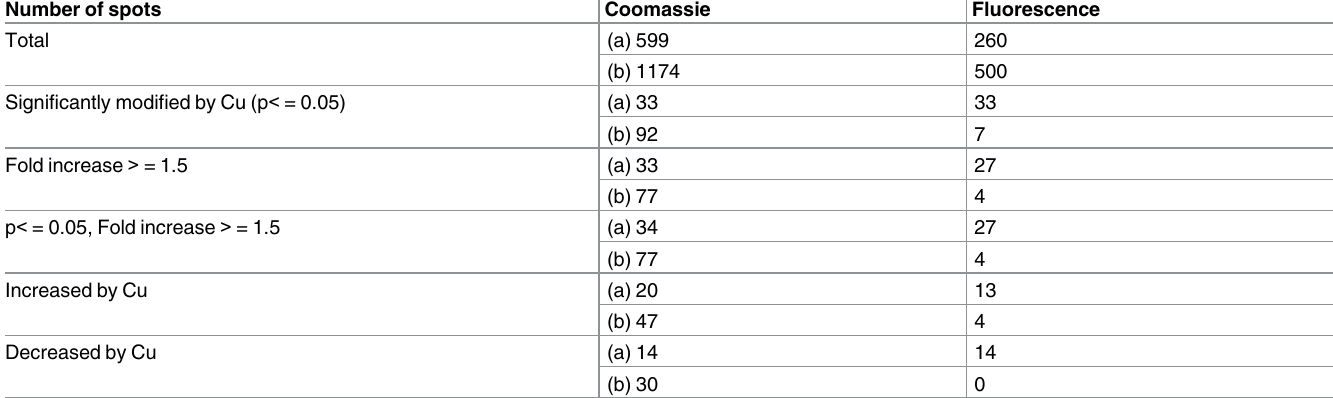
Table 5. Proteins containing thiol groups (IAF labeling) in the seedlings (3 days-old) (a) and the cotyledons (9 days-old) (b) of germinated bean seeds in the presenceof H 2 O (CTR) or 200 μ M